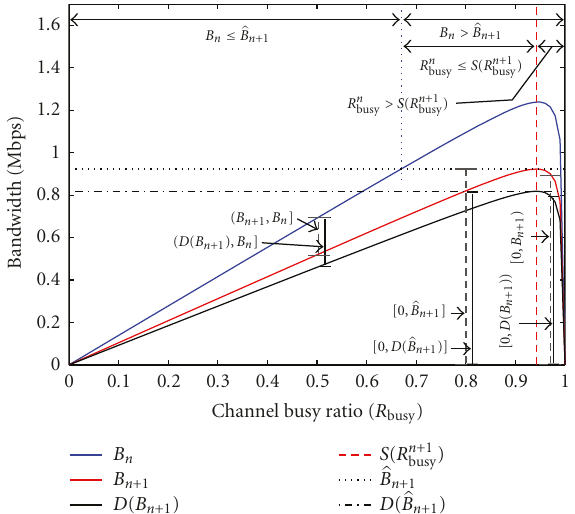
Figure 5: Numerical analysis of achievable throughput estimation /w and /wo rate discount for n = 3 and FER = 0 . 1.